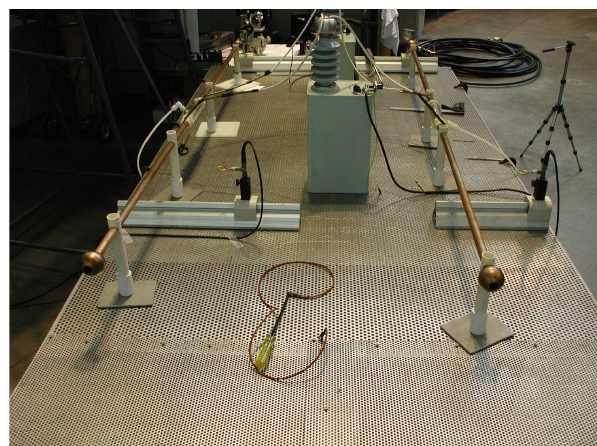
Fig. 6. Photograph of a pair of 80-MHz laser triggered (via pres- surized SF 6 spark gaps) Hertzian antennas set up at UCLA, over a perforated aluminum ground plane. Each λ /4 antenna half is 93cm long and is mounted 17cm above ground. The ± 0–75-kV charg- ing power supplies are between the two antennas. The laser beam splitters are in the background. Single turn loops for monitoring the antenna currents are mounted on the triangular optical rails. The laser beams pass into the antennas through holes in the high volt- age ends, traveling inside the hollow conductors to a lens (which also serves as a high pressure spark gap window) which focuses the laser pulse, through a hole in the near electrode, onto a heavy metal (W-Cu) insert in the far electrode. The focused laser energy generates ultraviolet light that ionizes the SF 6 gas in the two